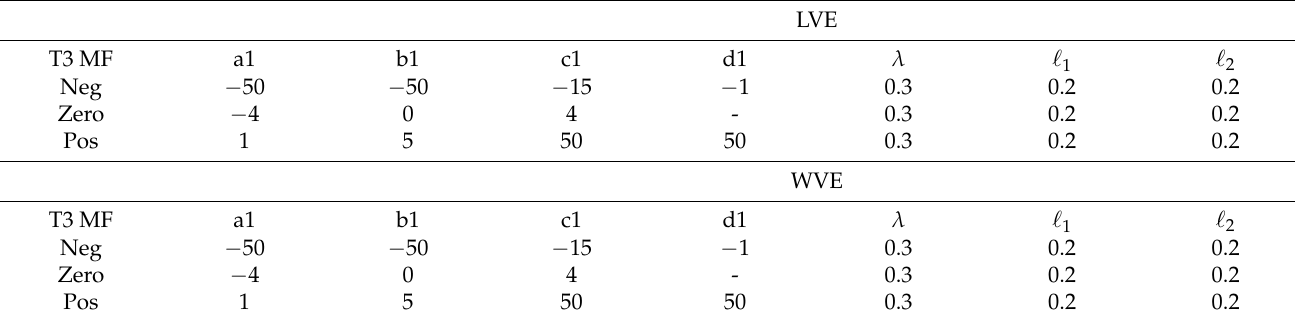
Table 2. T3 MF antecedent parameters.